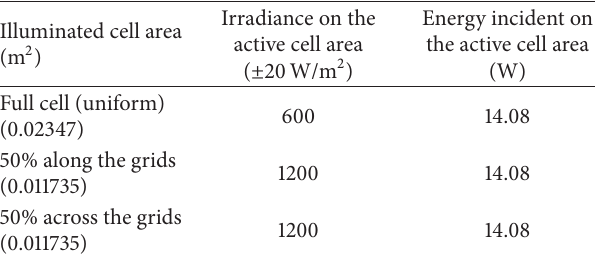
Table 5: Irradiance and energy flux incident on the active PV cell area for uniform and nonuniform illumination